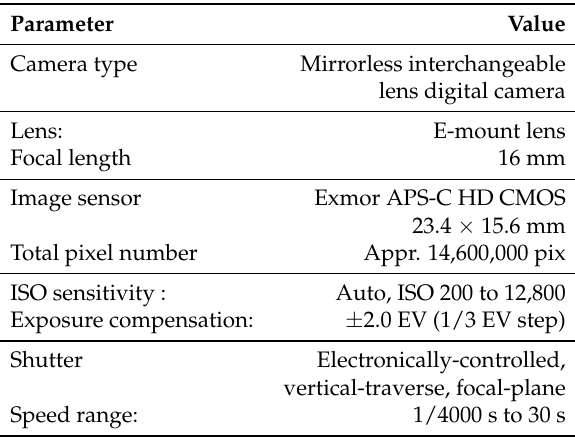
Table 1. Main characteristics of SONY NEX-5 camera.